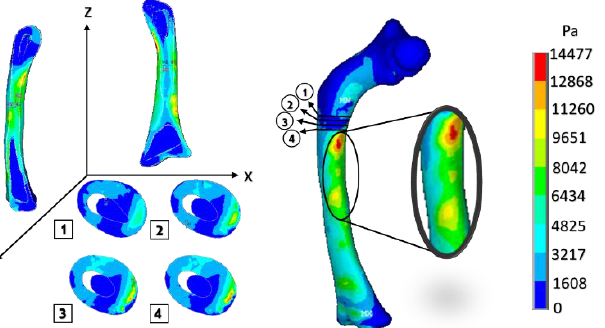
Figure 17. Orthotropic analysis. Von Mises stress showing maximum stress of 9.583 Pa.